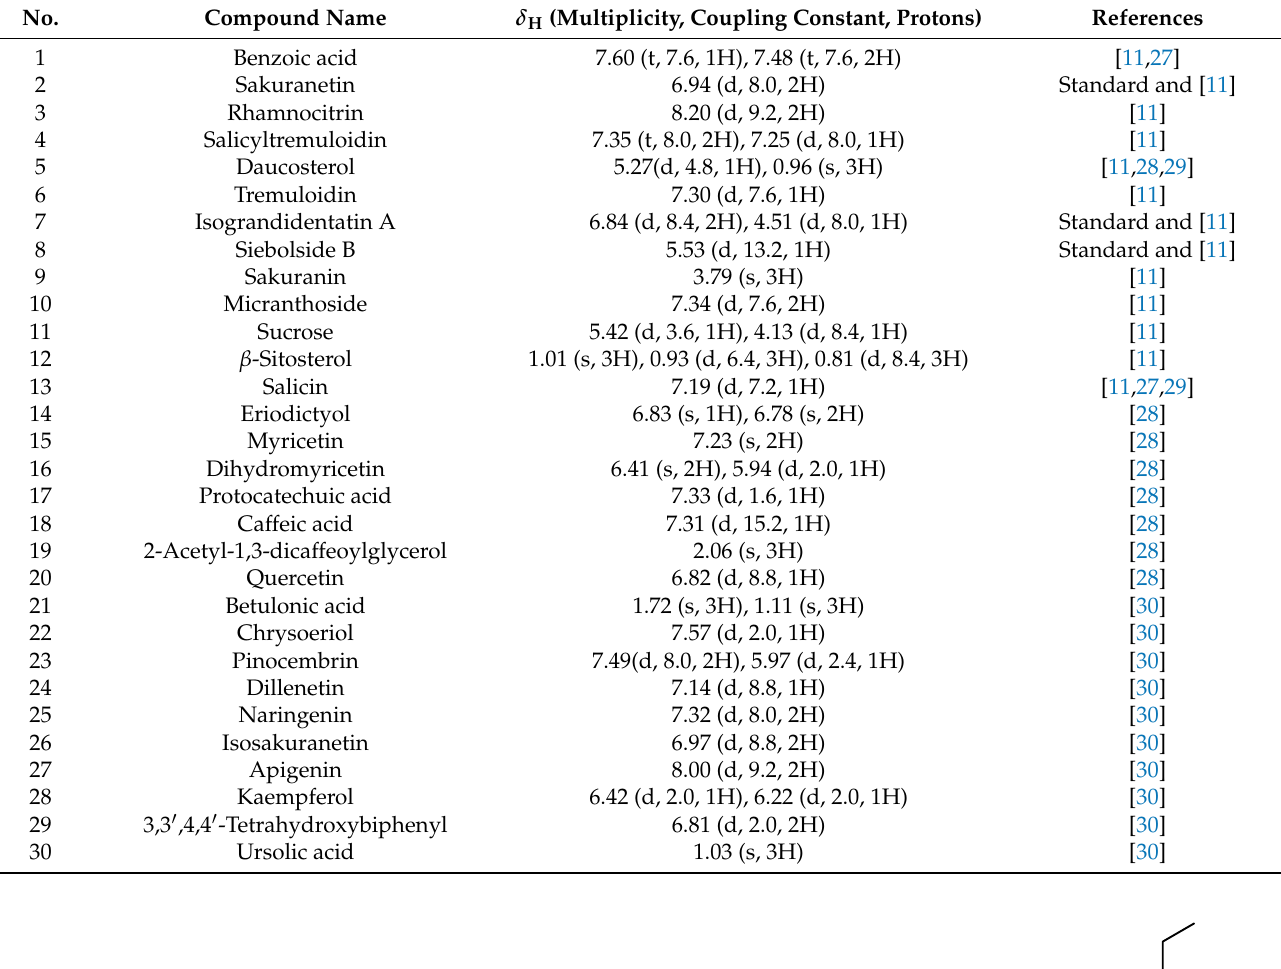
Table 1. The assigned compounds with 1 H NMR spectra (s, singlet; d, doublet; and t, triplet).